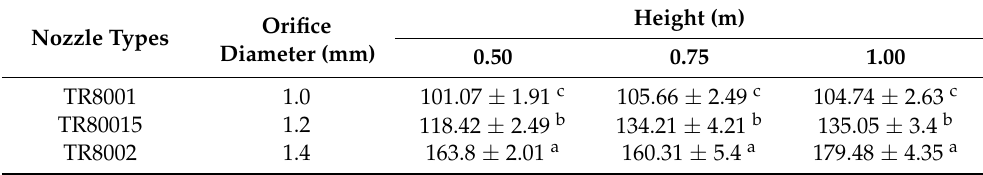
Table 2. Effect of the orifice diameters on VMD ( µ m).